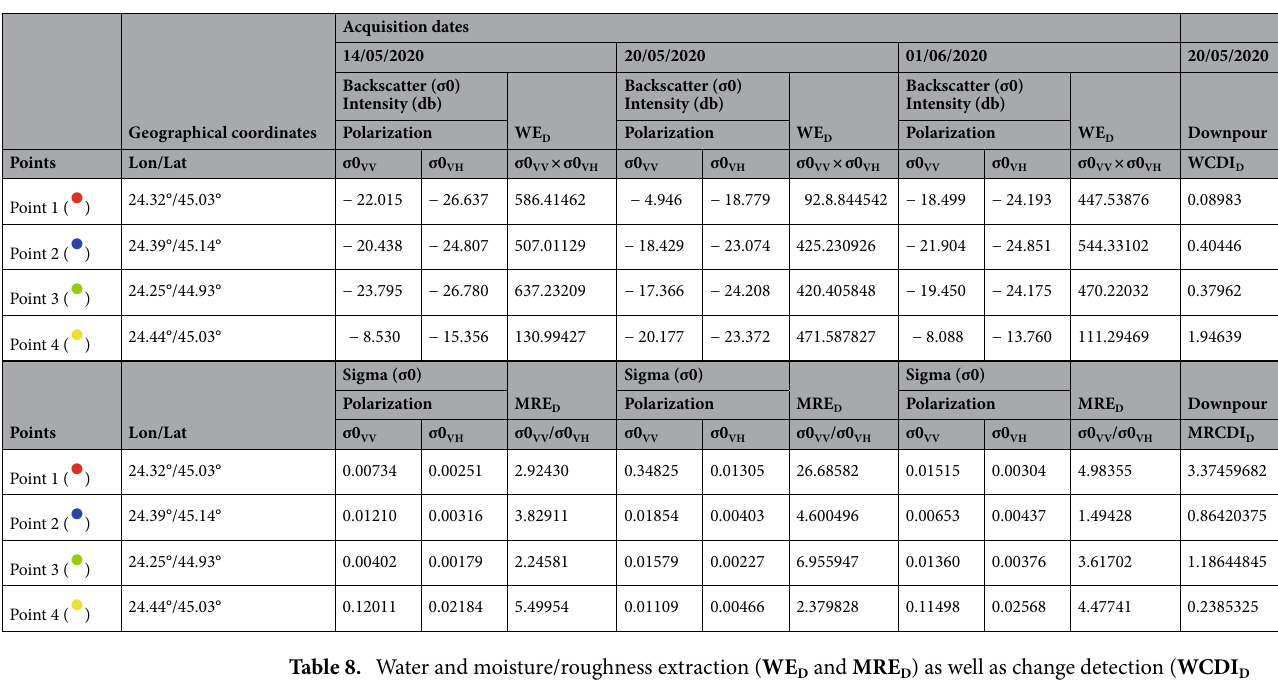
Table 8. Water and moisture/roughness extraction ( WE D and MRE D ) as well as change detection ( WCDI D and MRCDI D ) of the four points of the representative locations of the scene.